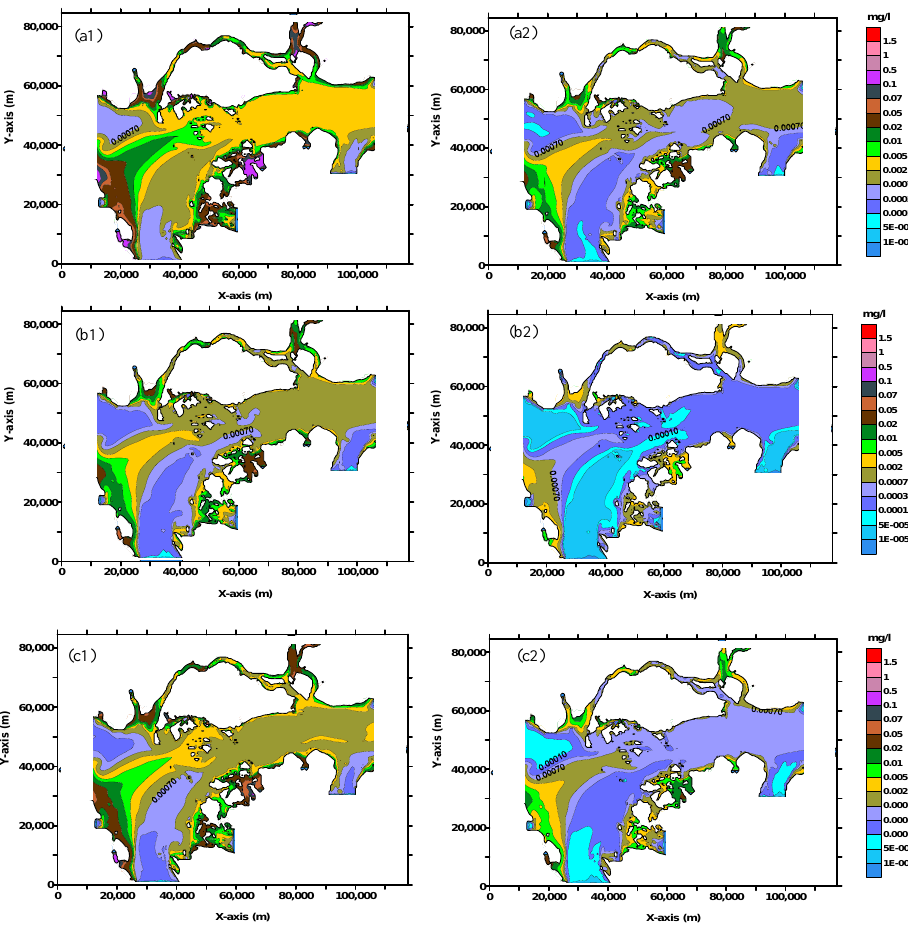
Fig. 7. The absolute change of (a) nitrate-nitrogen, (b) ammonium and (c) organic nitrogen concentration at surface water from baseline due to the atmospheric wet deposition during (1) hazy and (2) non-hazy days.